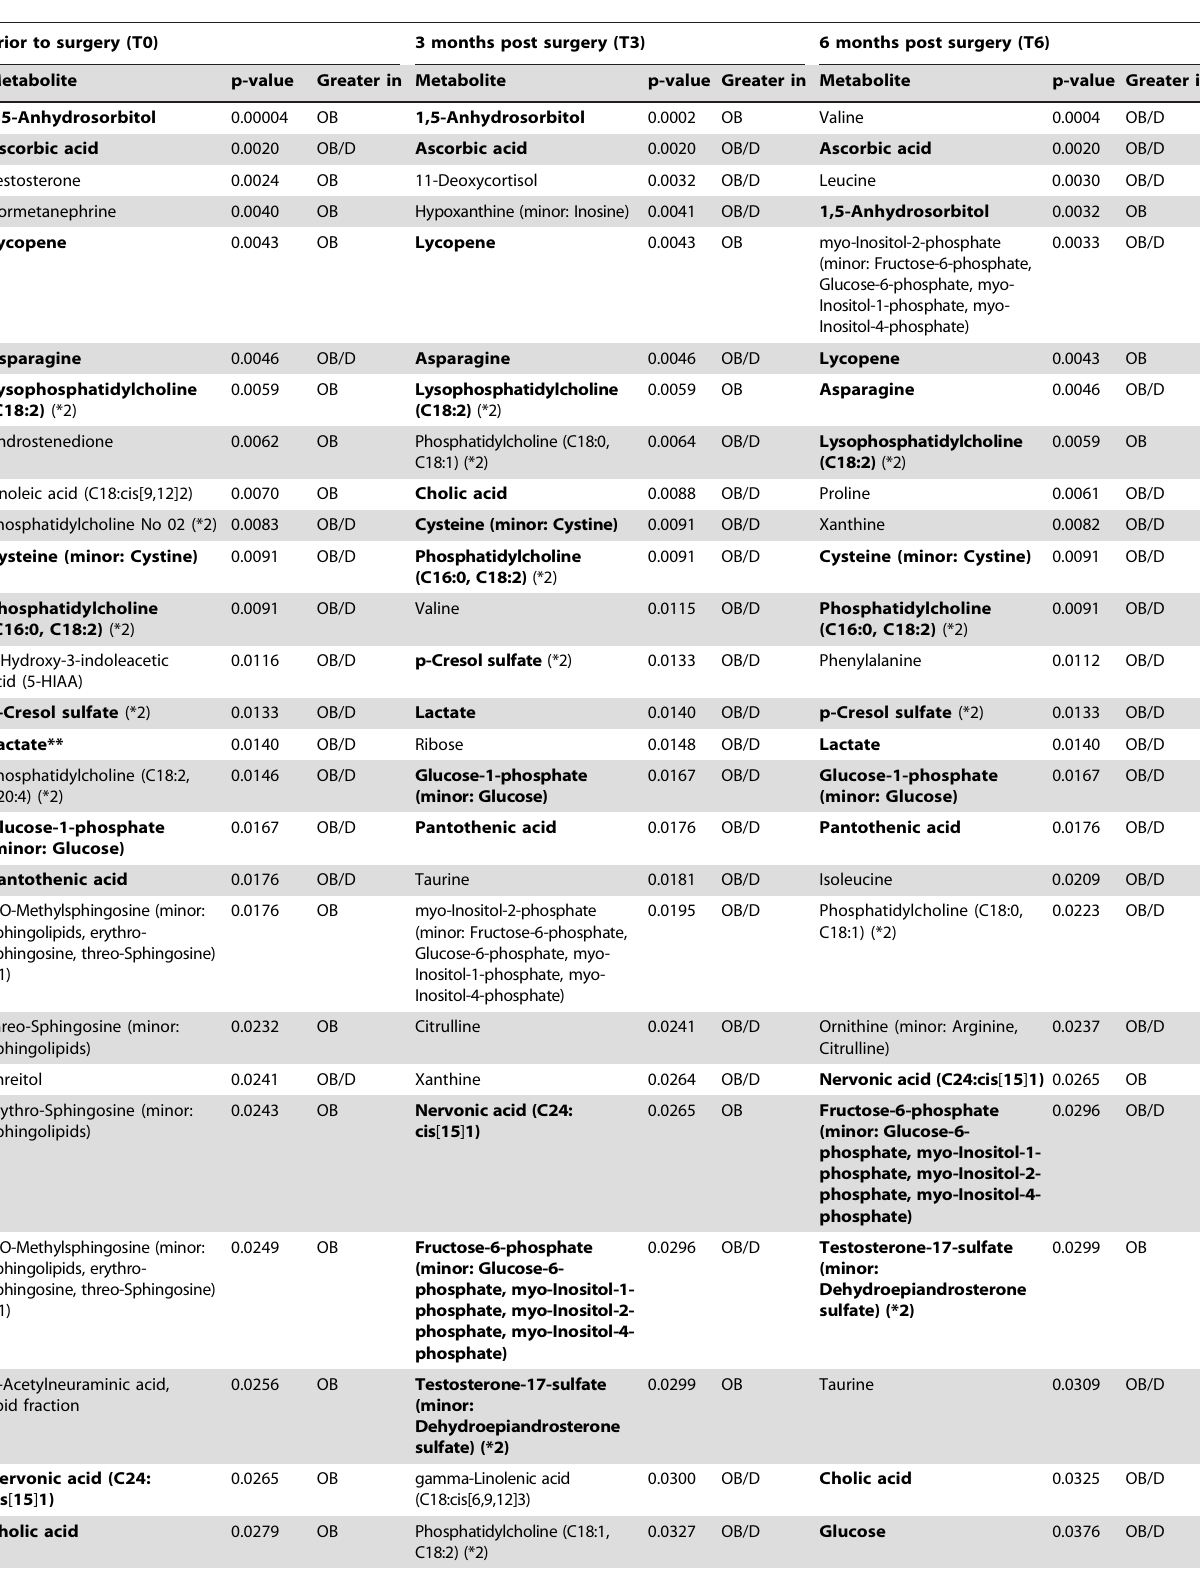
Table 2. Metabolite lists differentiating OB from OB/D subjects at each time point.